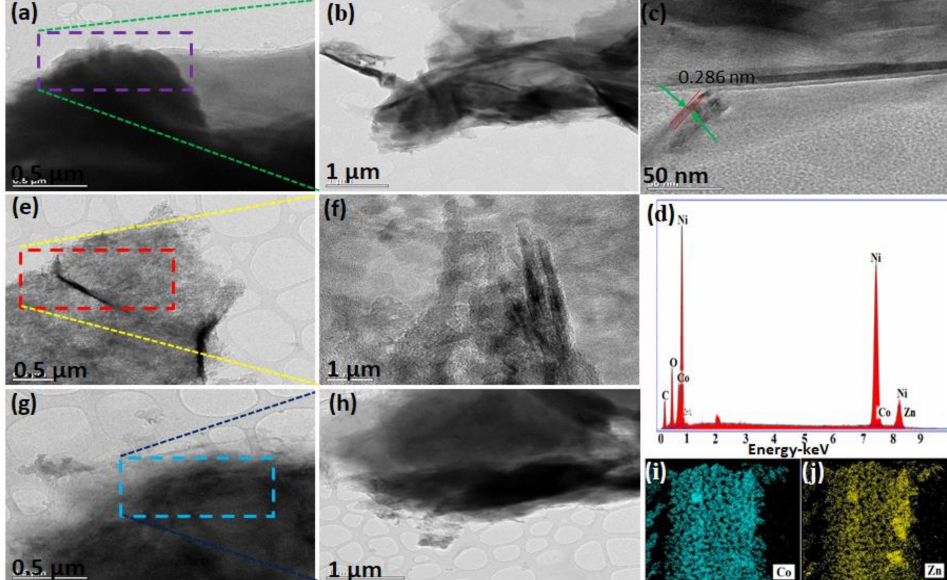
Figure 4. Transmission electron microscopy (TEM) and High resolution (HR-TEM) images for CZ3h, CZ1h and CZ7h composites. ( a – c ) presents low and high magnification TEM images of the CZ3h composite electrode and ( d ) Energy dispersive x-ray spectroscopy (EDS) spectrum, ( e , f ) CZ1h composite electrode, ( g , h ) CZ7h composite electrode and ( i , j ) elemental mapping images of Co and Zn.